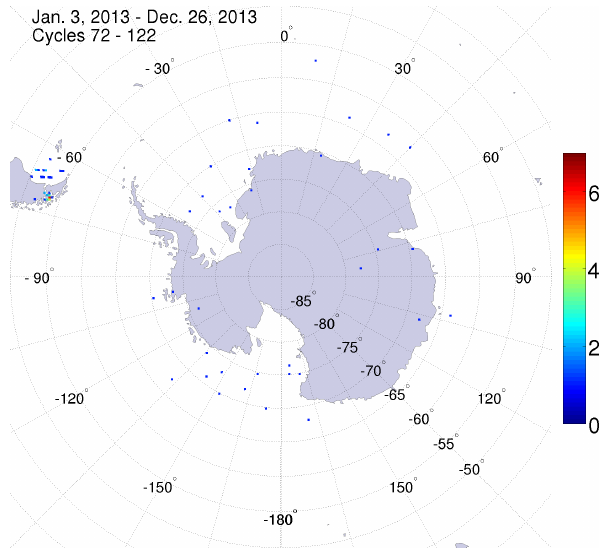
Fig. 2. Map of radio frequency interference (RFI) occurrences (the number of footprint with either a moderate or severe RFI contam- ination) during the entire year 2013 in the Southern Hemisphere, considering both ascending and descending